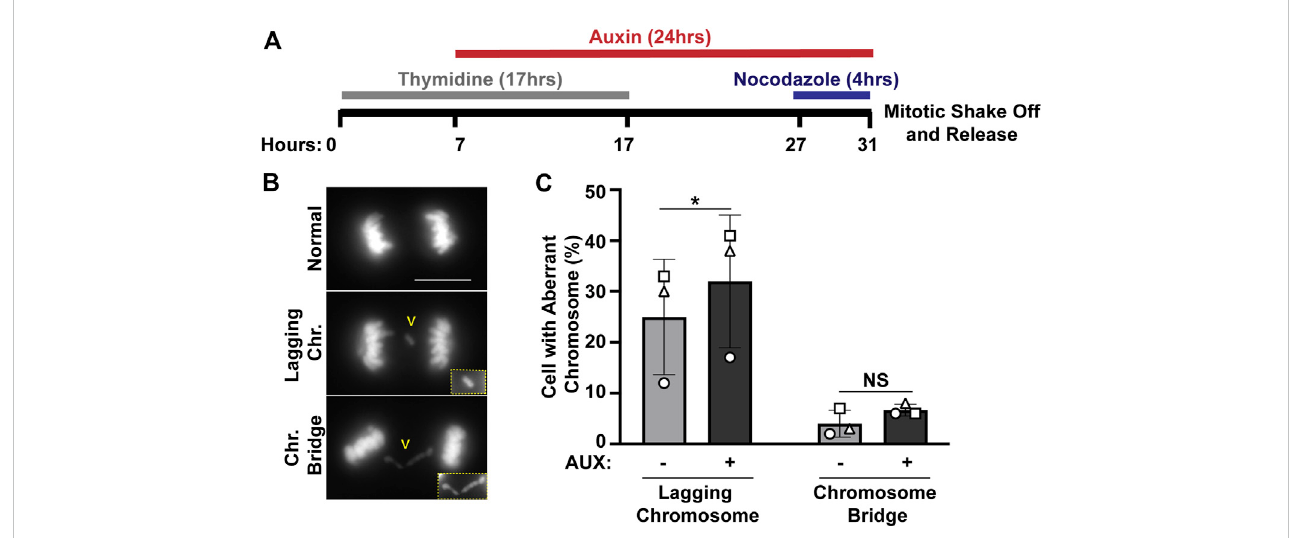
FIGURE 2 The EWSR1 knockdown promotes induction of lagging chromosome during anaphase. (A) . Schematic diagram for the mitotic synchronization of EWSR1 knockdown cells using Thymidine and Nocodazole, followed by the mitotic shake-off and release from the mitotic arrest for 60 min. (B) . Representative images of chromosomes; normal (top panel), lagging chromosome (middle panel) and chromosome bridge (bottom panel). Yellow square highlights the magni fi ed images of either lagging chromosome or chromosome bridge. Chr.; chromosome, Scale bar = 10 um. (C) . Percentages of anaphase cells with lagging chromosomes (left graph) and of chromosomal bridges (right graph) in AUX- and AUX + cells (Total 34-104 anaphase cells per sample, n = 3 experiments). * p < 0.05. (paired t-test), NS; Non-Signi fi